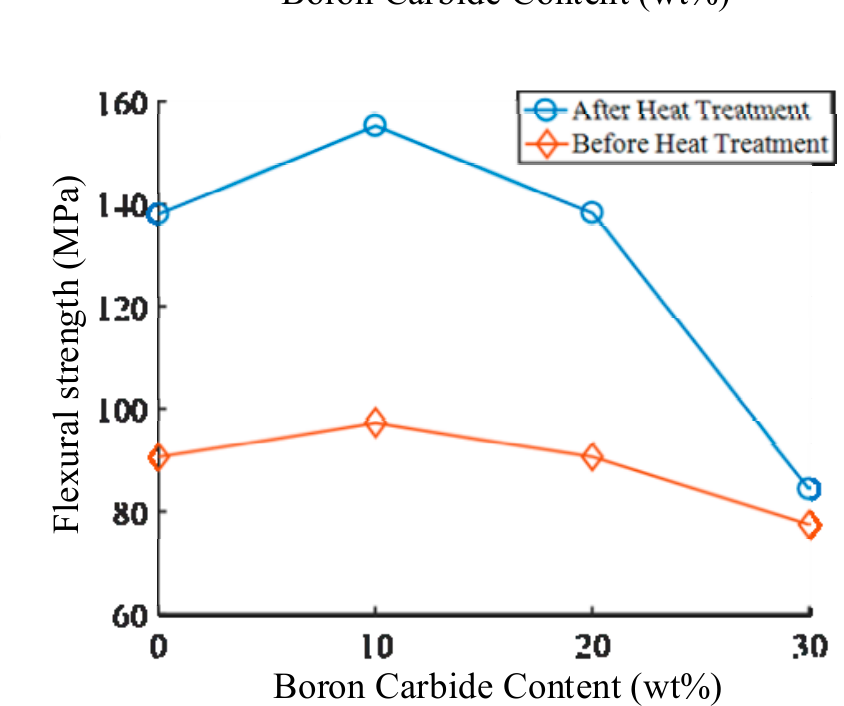
Figure 9. Tensile and flexural strengths of new composite shielding materials. ( a ) Test result of tensile experiment and ( b ) test data of flexural experiments.